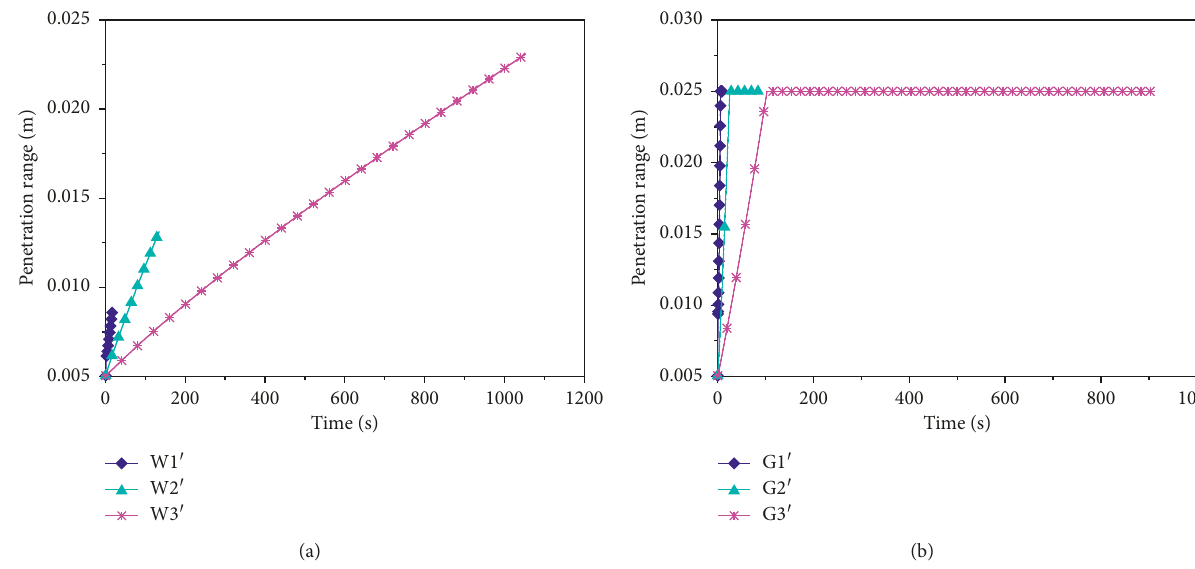
Figure 17: Plots of the seepage range with time during fracturing (II). (a) Water fracturing. (b) Nitrogen gas fracturing. Table 10: Results of the seepage rate (II). Specimen